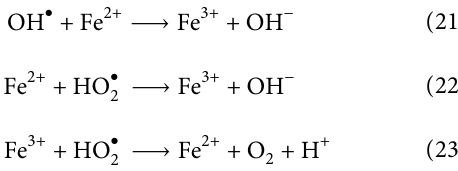
algorithm ( ga function available in the MATLAB ® software).